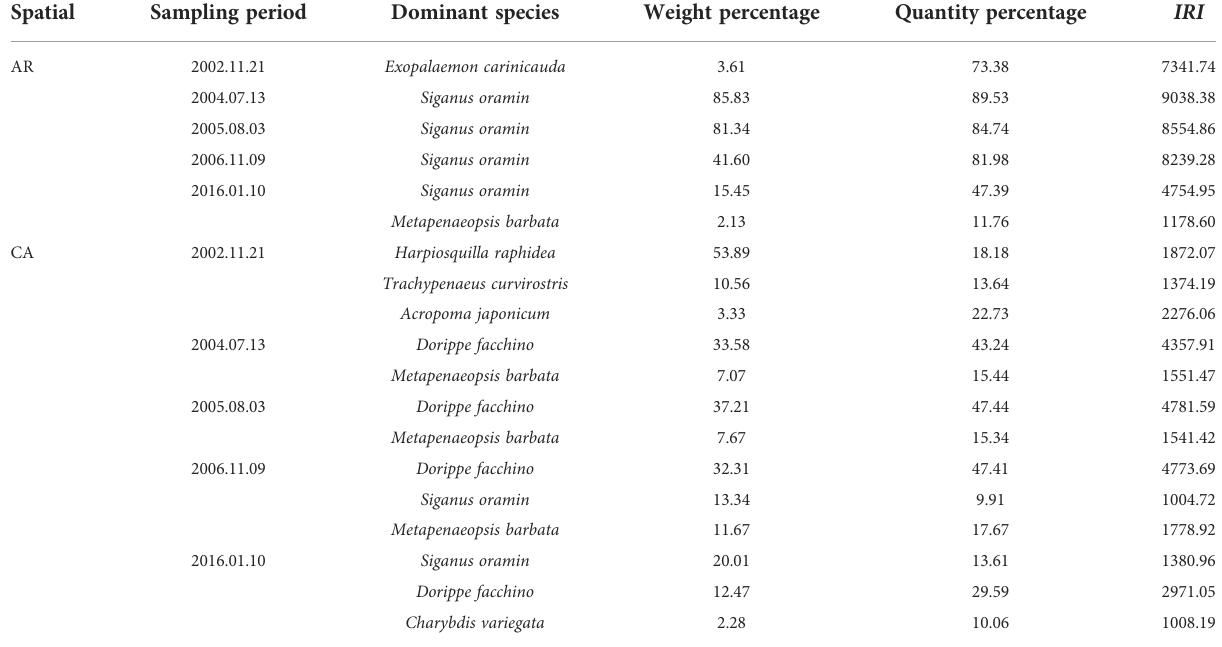
TABLE 4 Dominant species of nekton community in AR and CA habitat surveyed during trawl net sampling period. Spatial Sampling period Dominant species Weight percentage Quantity percentage IRI